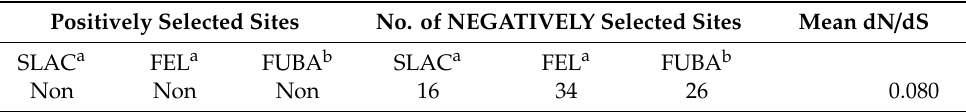
Table 3. Selection sites detected in the VP1 protein region of